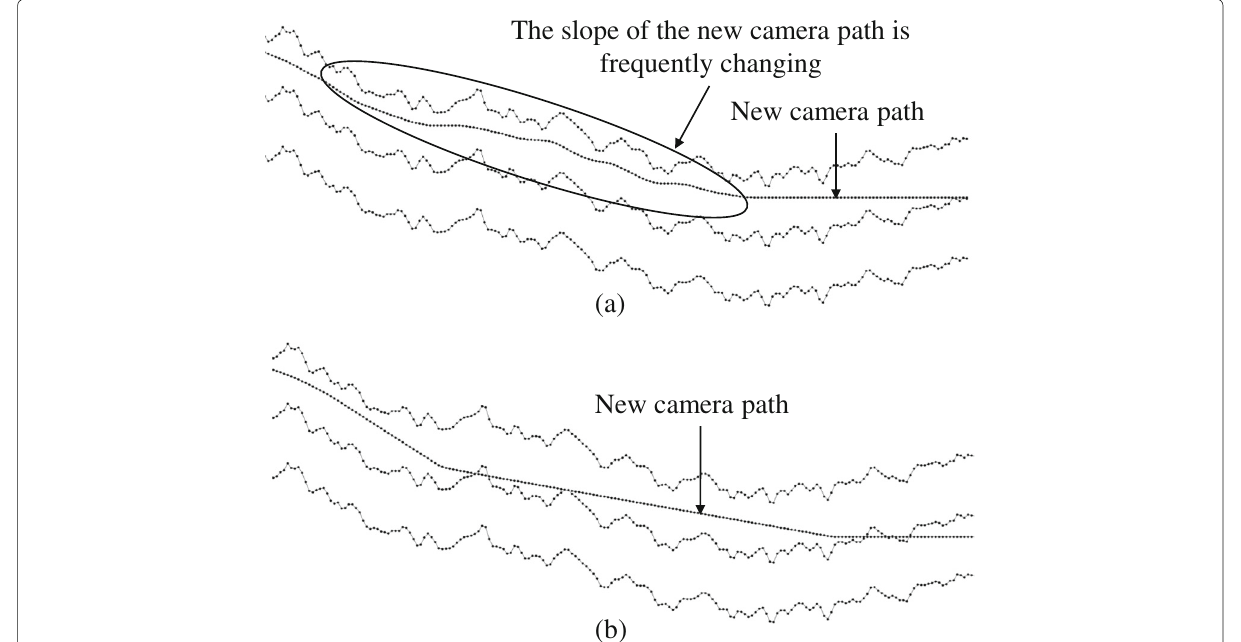
Fig. 10 a Without C L ( n , i ) and b with C L ( n , i ) in Eq. (4). K is set at